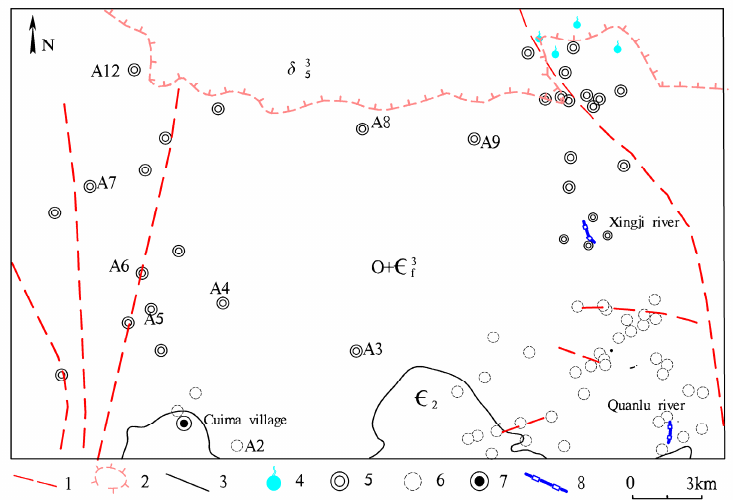
Figure 2. Map of tracer monitoring points. 1: fault; 2: magmatic rock; 3: Cambrian Fengshan Formation bottom limit; 4: spring group; 5: Cambrian Zhangxia aquifer monitoring point; 6: Ordovician aquifer monitoring point; 7: tracer drop well in Cuima village; 8: tracer drop river course in leakage section of Xingji and Quanlu river.